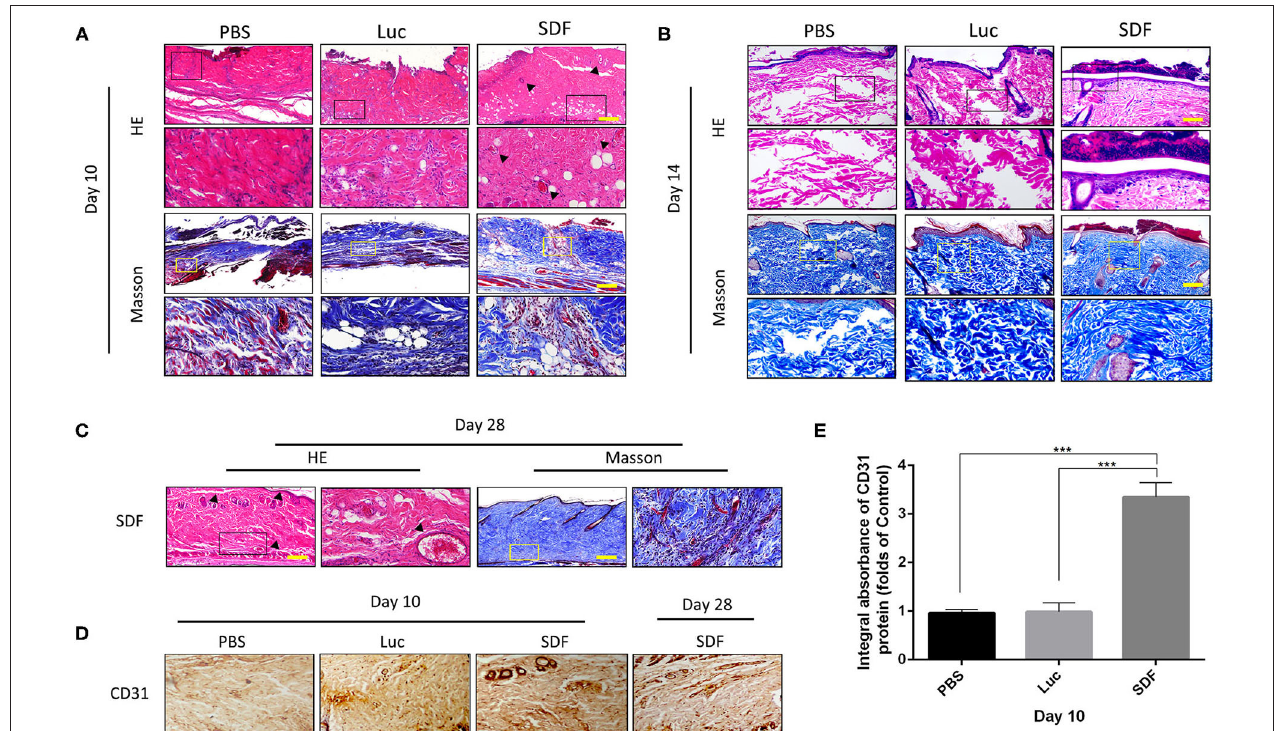
FIGURE 5 | Histological evaluation of the skin flaps. (A–C) H&E and Masson’s trichrome stained tissue sections from each group after 10, 14, and 28 days treatment. Black dotted square boxes indicate the location of microvessel (scale bar: 200 µ m). (D) Immunohistochemical staining of CD31 expression in skin flaps of each group. (E) Quantification of immunohistochemical data. Data represent the mean ± SD ( n = 4). *** P <